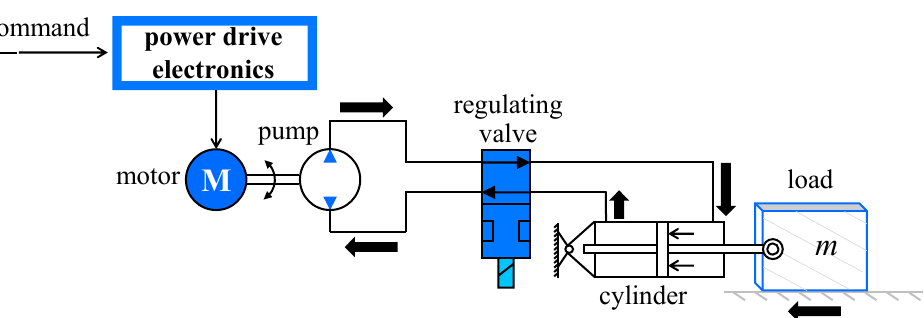
Figure 1. Schematic diagram of an electro-hydrostatic actuator (EHA).